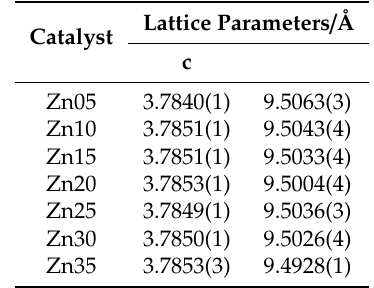
Table 2. Lattice parameters refined by Rietveld method for the crystalline anatase-type phase according to the PXRD measurement results depicted in Figure 5. Catalyst